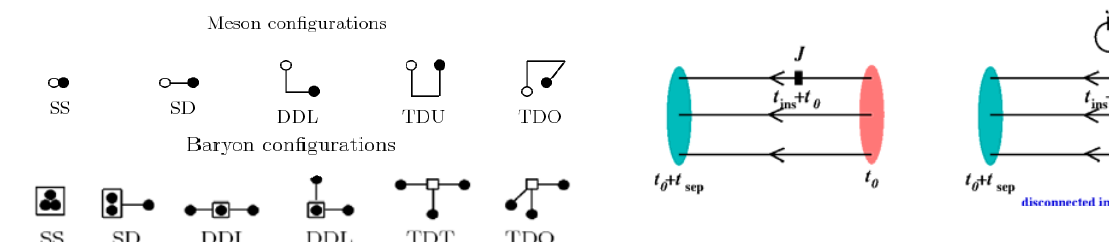
Figure 1. Spatial configurations of the meson and baryon opera- tors in terms of displaced quark fields that we use. SS stands for single site, SD for singly displaced, DDL for doubly displaced in an L configuration, TDO for triply displaced orthogonal, and so on.